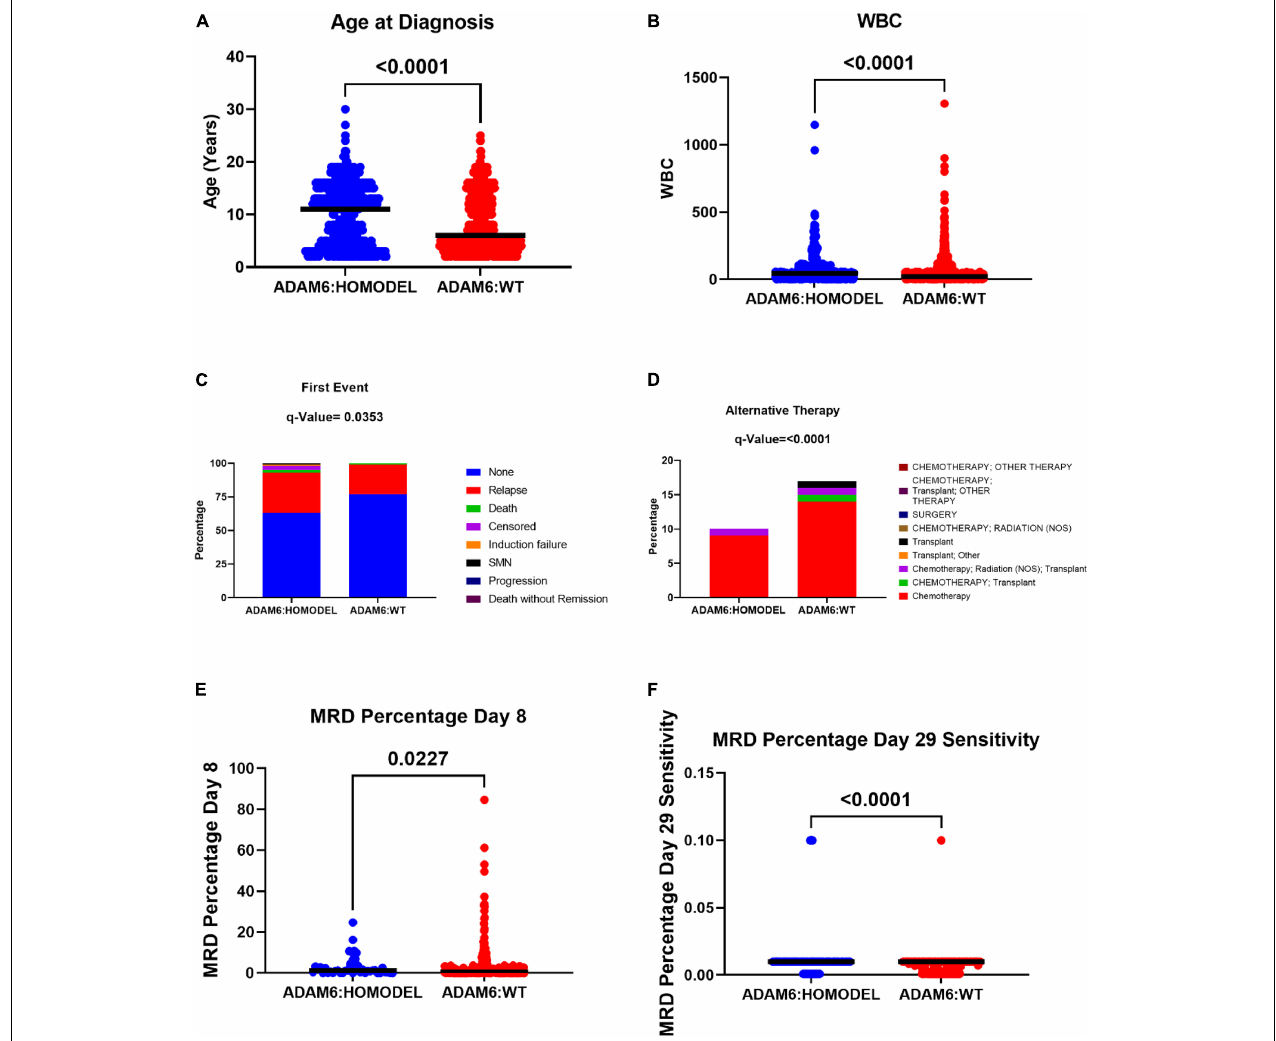
FIGURE 3 | The difference in the clinical attributes between ADAM6:HOMDEL versus WT:ADAM6 patients.